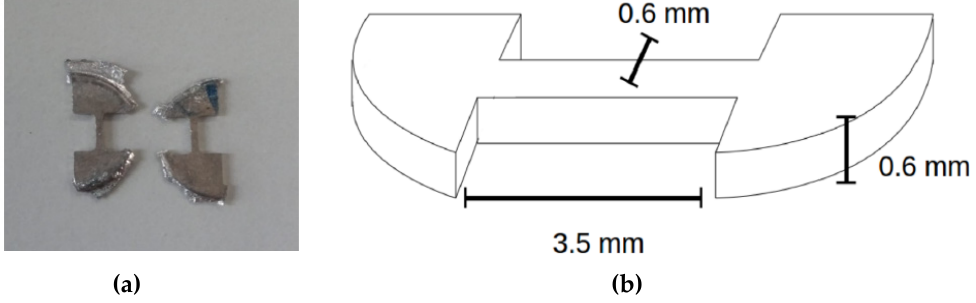
Figure 2. ( a ) Tensile test samples punched from Mg alloys in question, ( b ) dimensions of a punched sample.